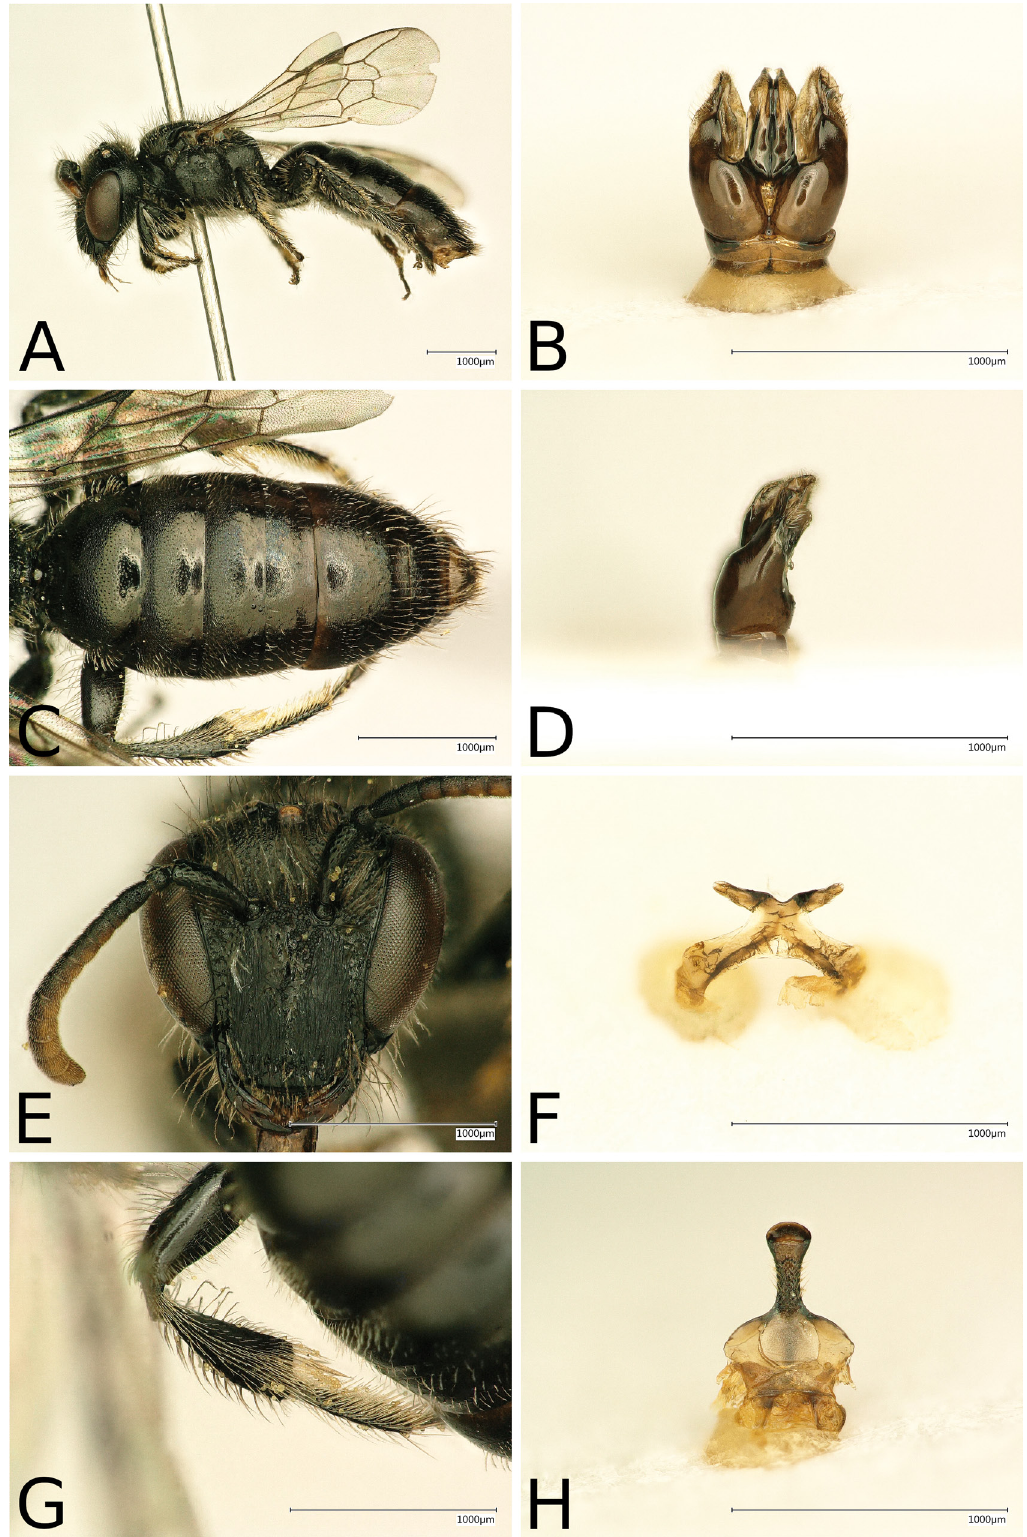
Fig. 4. Scrapter hergi Kuhlmann sp. nov., ♂, holotype (RCMK). A . Lateral view. B . Genitalia (dorsal view). C . Metasoma (dorsal view). D . Genitalia (lateral view). E . Head. F . S7 (dorsal view). G . Hind tibia. H . S8, apical